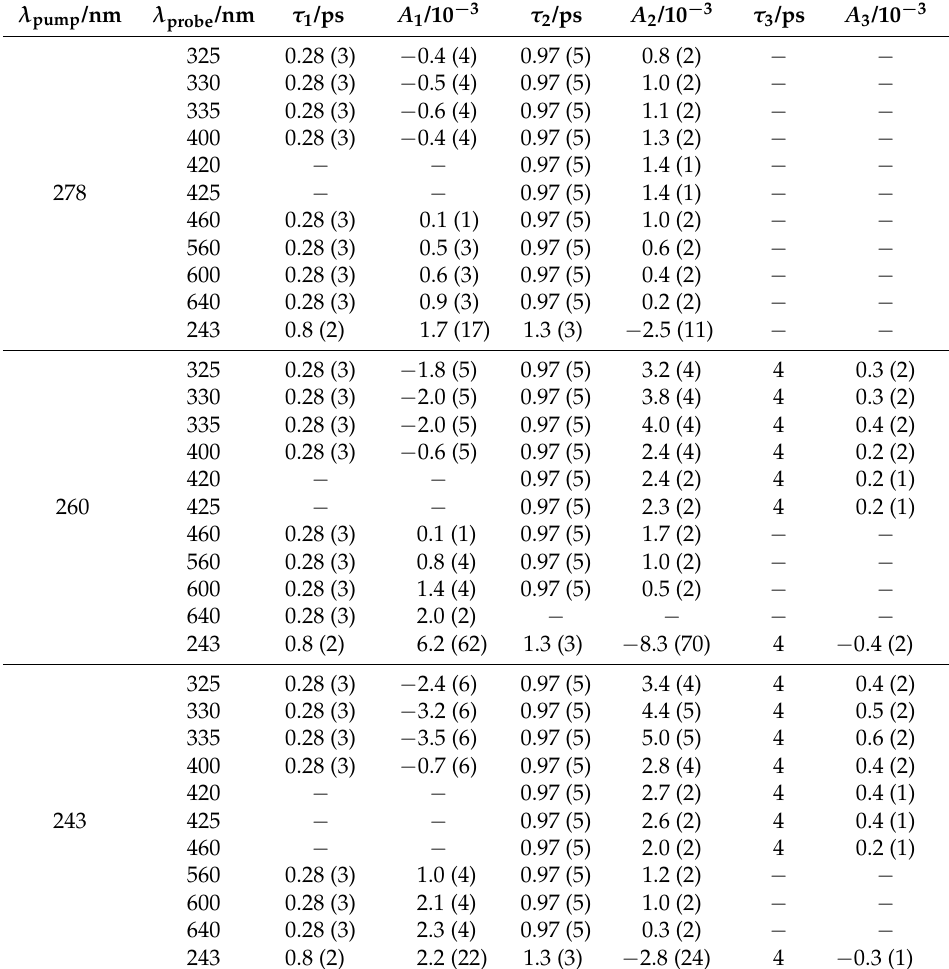
Table A4. Decay times τ i and associated amplitudes A i from the preliminary simultaneous analysis at selected probe wavelengths of the observed changes in optical density in the transient absorption measurements for XMP − after excitation at λ pump = 260, 260 and 243 nm (2 σ error limits of last digits in